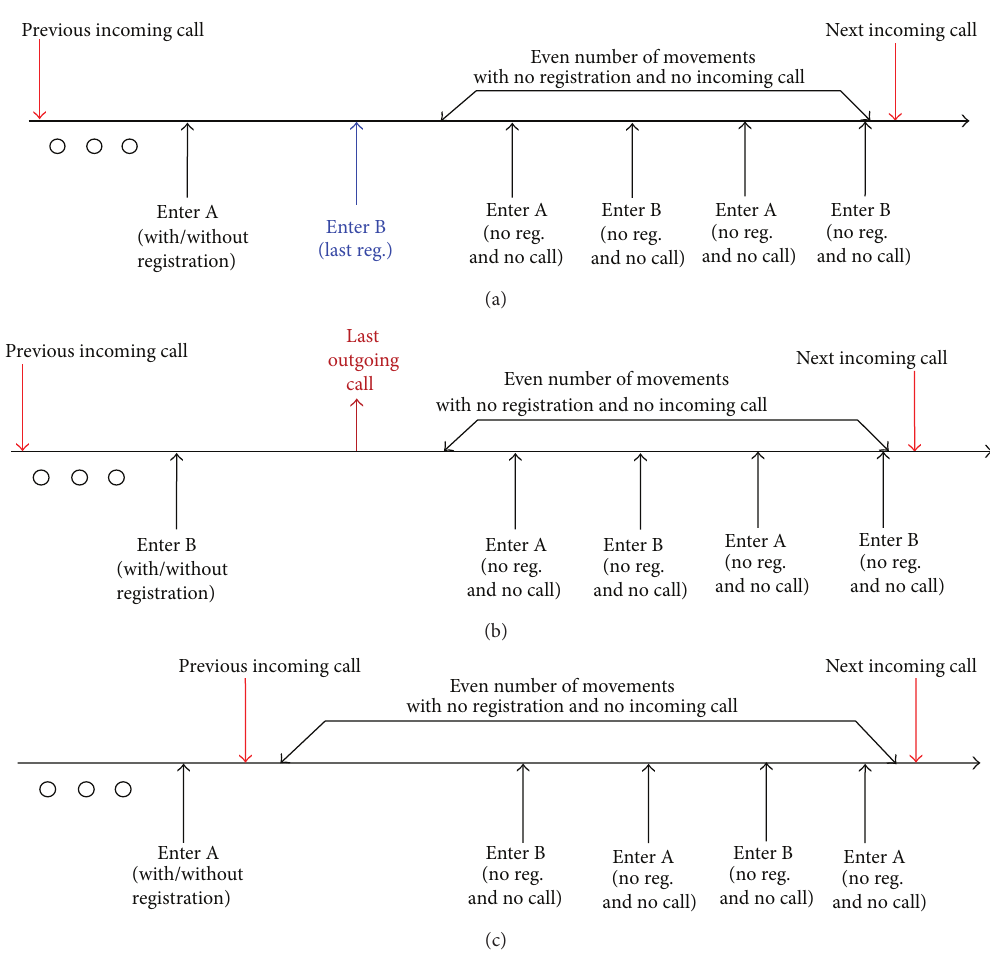
Figure 7: Situations when the system has the correct view of the latest visited zone. (a) Case 1: the last registration is followed by an even number of movements. (b) Case 2: the last outgoing call is followed by an even number of movements with no registration and no outgoing call. (b) Case 3: there are an even number of movements with no registration and no outgoing call.